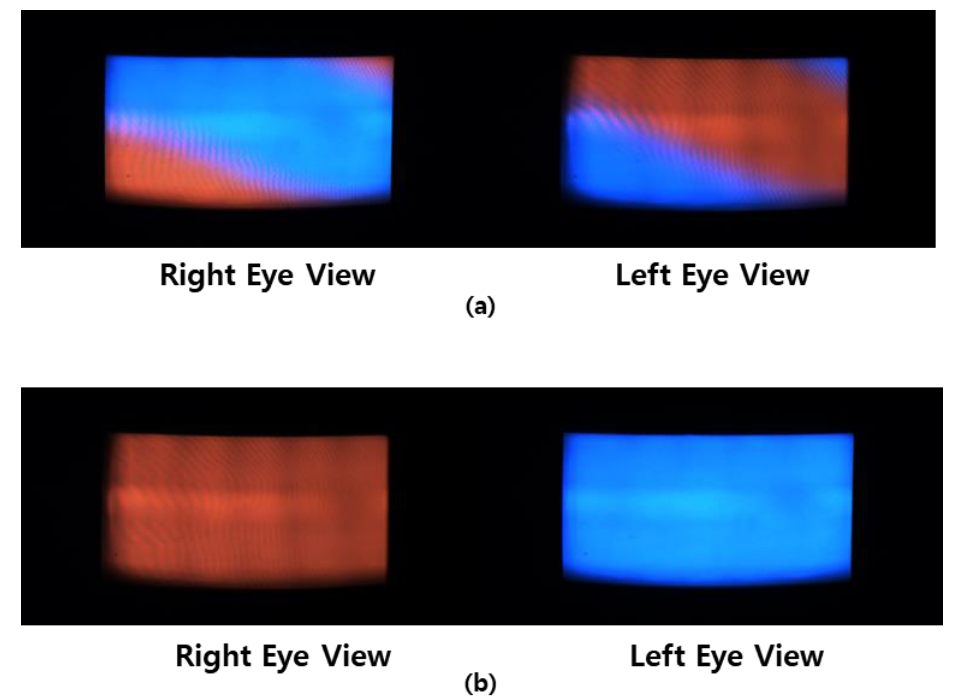
Figure 1. Eye-tracking-based 3D light field rendering results based on an input of a red right image and a blue left image. ( a ) 3D crosstalk occurs when the error associated with the eye-tracking accuracy exceeds the 3D crosstalk margin. ( b ) 3D rendered results corresponding to high-accuracy eye tracking with smaller error than the 3D crosstalk margin. The 3D crosstalk margins of the AR 3D HUD prototype are 12 mm, representing the eye-tracking precision